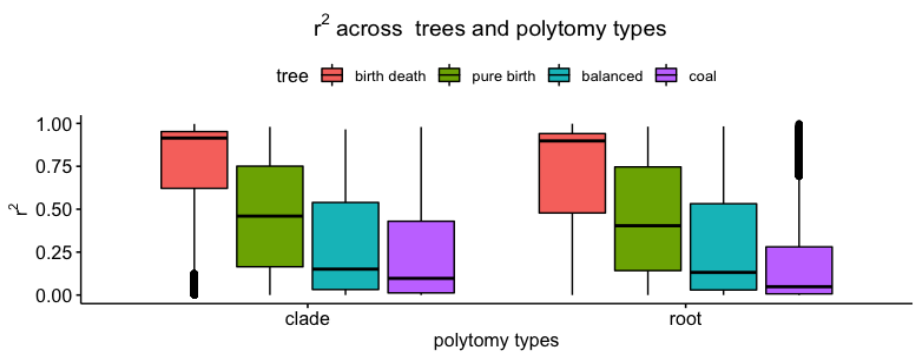
Figure 13. Comparison of r 2 across tree type and polytomy type. Higher values represent smaller differences between the observed data and the fitted values.